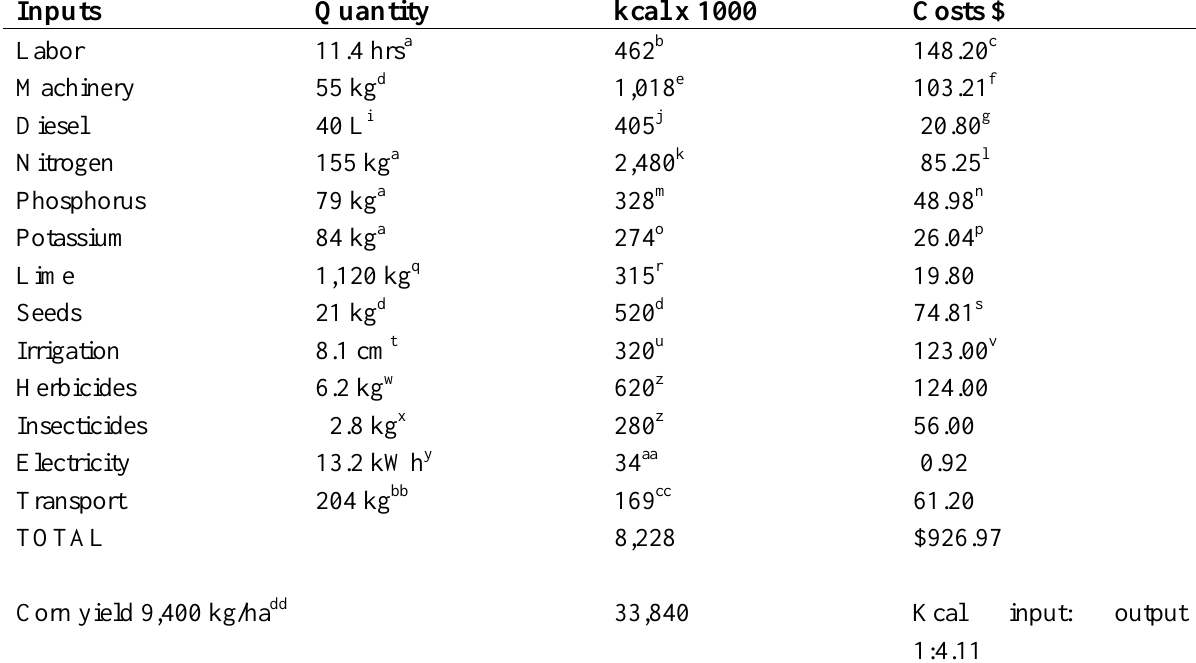
Table 5. Energy inputs and costs of corn production per hectare in the United